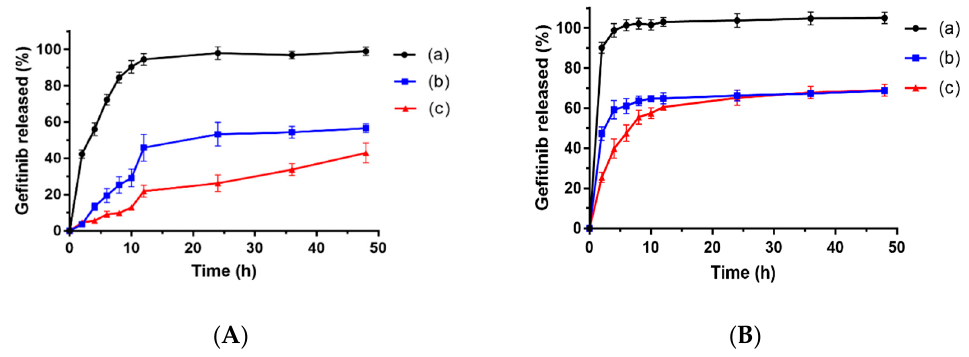
Figure 5. Drug release of different gefitinib formulations at ( A ) pH 7.4 and ( B ) pH 5.0. ( a ) gefitinib suspension, ( b ) GFB/FCPP NPs, and ( c ) GFB/FCPP-NEMs. Each data point represents the mean ± SD ( n = 3).